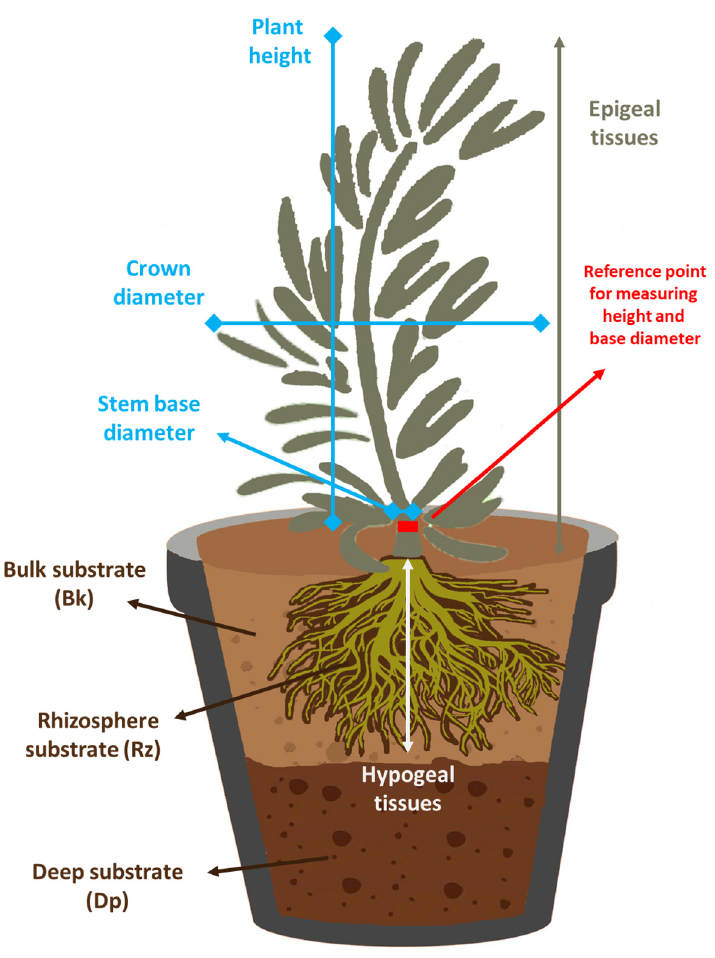
Figure 1. Schematic representation of the plant growth parameters and the different matrices used for determination of the substrate